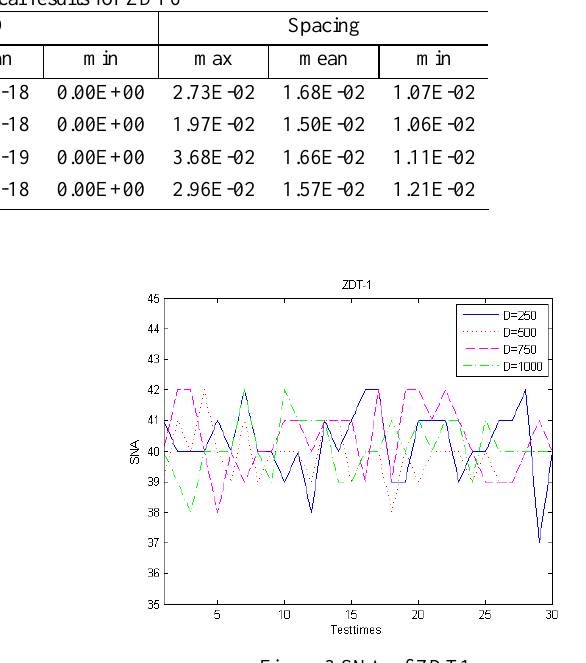
Table 5. Statistical results for ZDT6